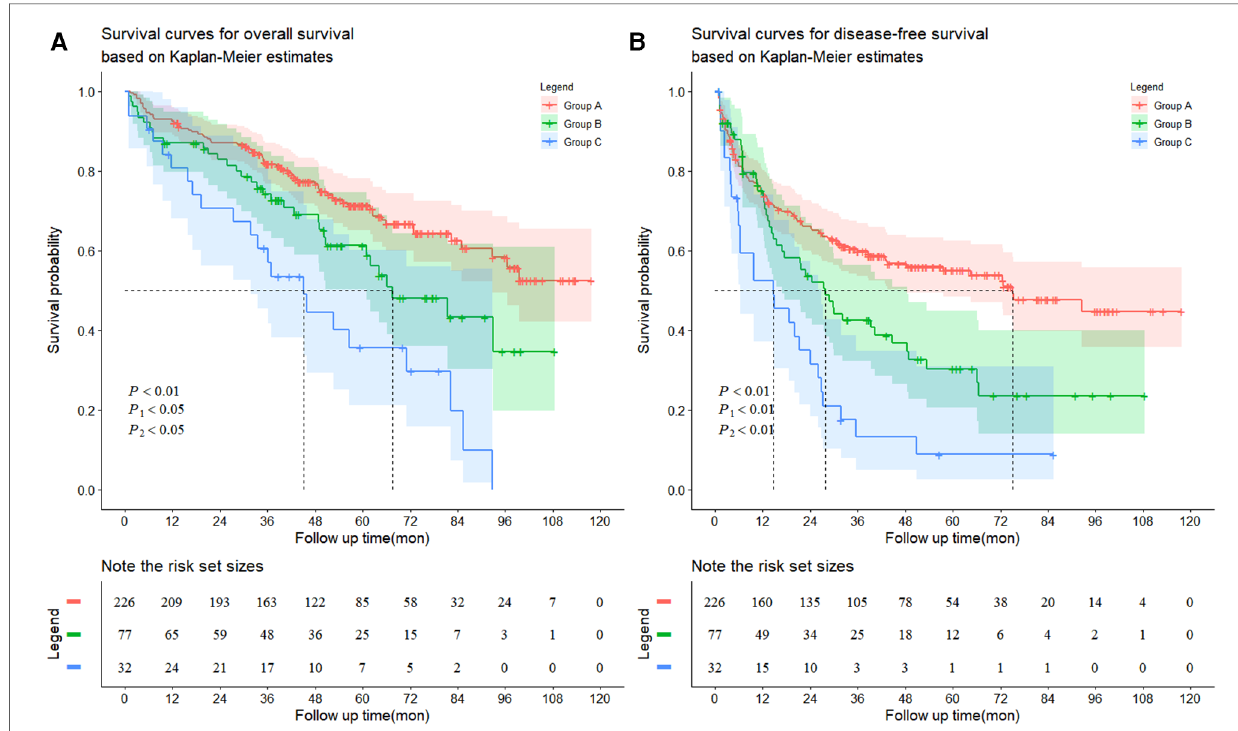
FIGURE 2 Kaplan-Meier survival curves for ( A ) overall survival and ( B ) disease-free survival. ( A ) The patients exhibited HCC without hypersplenism in the group A had much better overall survival rate than the patients with HCC and mild hypersplenism in the group B (the 1-, 3-, 5-, 7-, and 9-year overall survival rates: 92.5%, 81.8%, 71.3%, 62.5% and 52.5%, respectively vs. 87.0%, 74.2%, 61.3%, 43.2% and 34.6%, respectively, P 1=0.0201). The patients in the group B had much better overall survival rate than the patients with HCC and severe hypersplenism in the group C (the 1-, 3-, 5-, 7-, and 9-year overall survival rates: 87.0%, 74.2%, 61.3%, 43.2% and 34.6%, respectively vs. 80.8%, 60.6%, 35.6%, 19.8% and 0%, respectively, P 2=0.0144). ( B ) The patients exhibited HCC without hypersplenism in the group A had much better disease-free survival rate than the patients with HCC and mild hypersplenism in the group B (the 1-, 3-, 5-, 7-, and 9-year overall survival rates: 74.2%, 59.9%, 55.0%, 47.7% and 44.7%, respectively vs. 75.1%, 42.6%, 30.3%, 23.5% and 23.5%, respectively, P 1=0.0053). The patients in the group B had much better disease-free survival rate than the patients with HCC and severe hypersplenism in the group C (the 1-, 3-, 5-, 7-, and 9-year overall survival rates: 75.1%, 42.6%, 30.3%, 23.5% and 23.5%, respectively vs. 53.4%, 13.1%, 8.7%, 8.7% and 8.7%, respectively, P 2=0.0049).